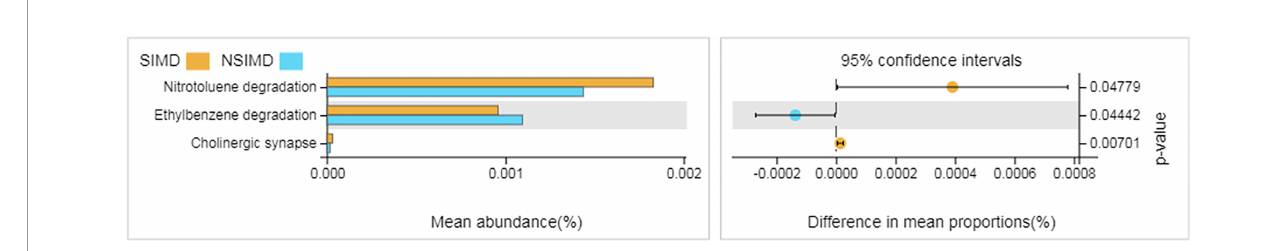
FIGURE 5 | Functional pathway analysis of gut microbiome between two groups. Microbial functions were predicted using Tax4Fun at the third level of the KEGG pathway and statistically analyzed by Welch ’ s t-test between groups. The graph on the right shows the difference between the con fi dence levels of the groups. KEGG, Kyoto Encyclopedia of Genes and Genomes.